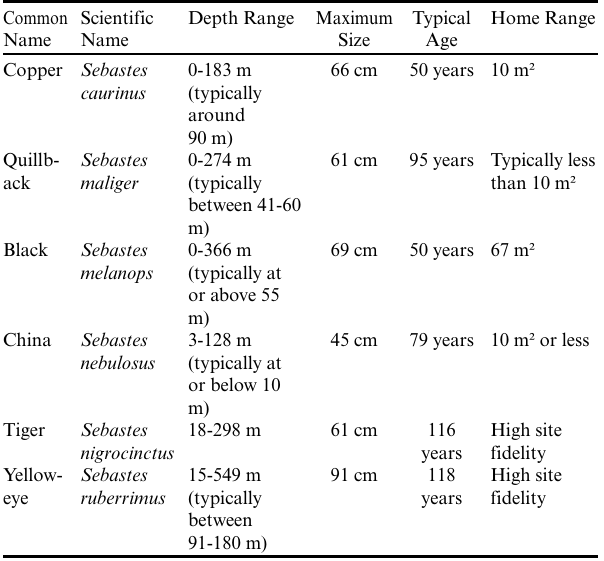
Table 1 . Life history characteristics of common inshore rockfish species in British Columbia (Love et al. 1991, Frid et al. 2013, Haggarty 2014).